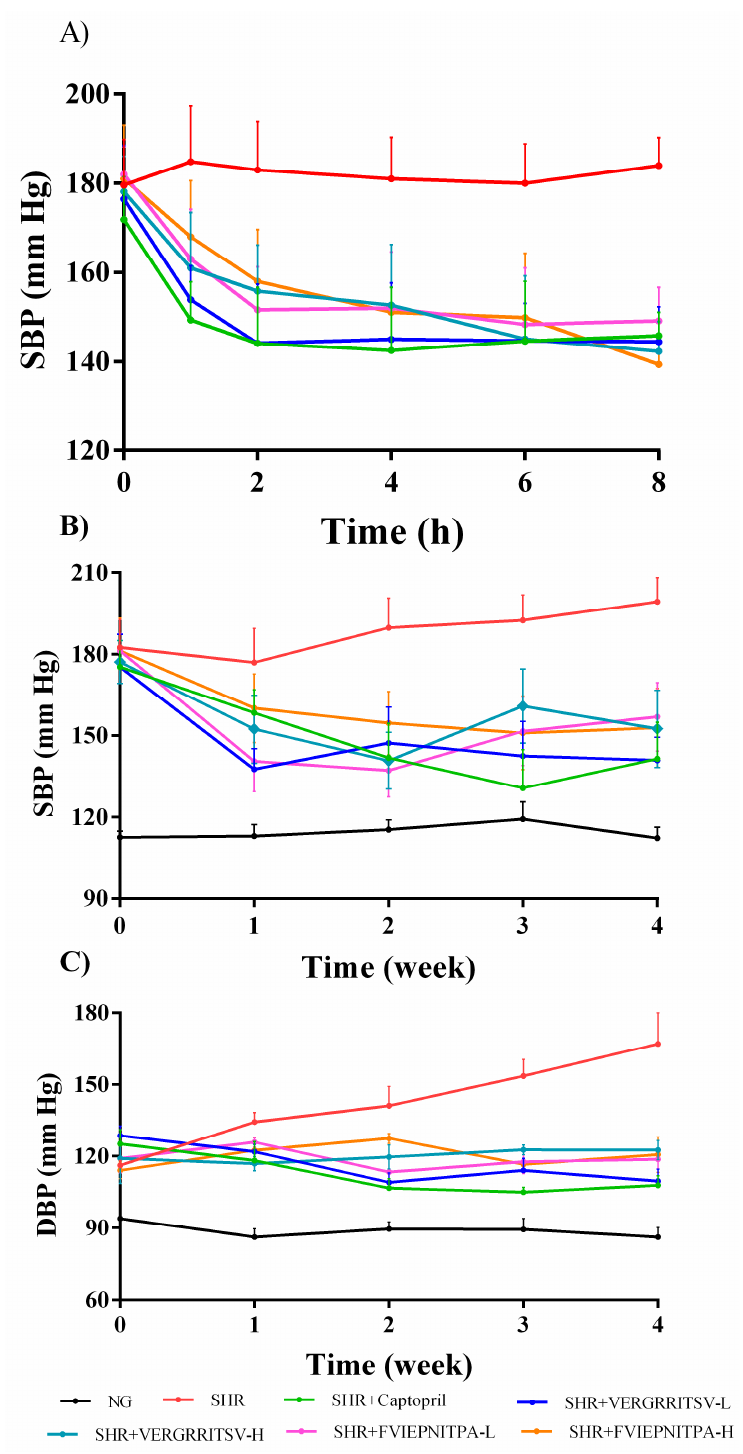
Figure 5. Effect of single oral administration (0–8 h) on SBP in SHRs ( A ); four weeks oral administra- tion on SBP ( B ), and DBP in SHRs ( C ). NG represents rats in the normal